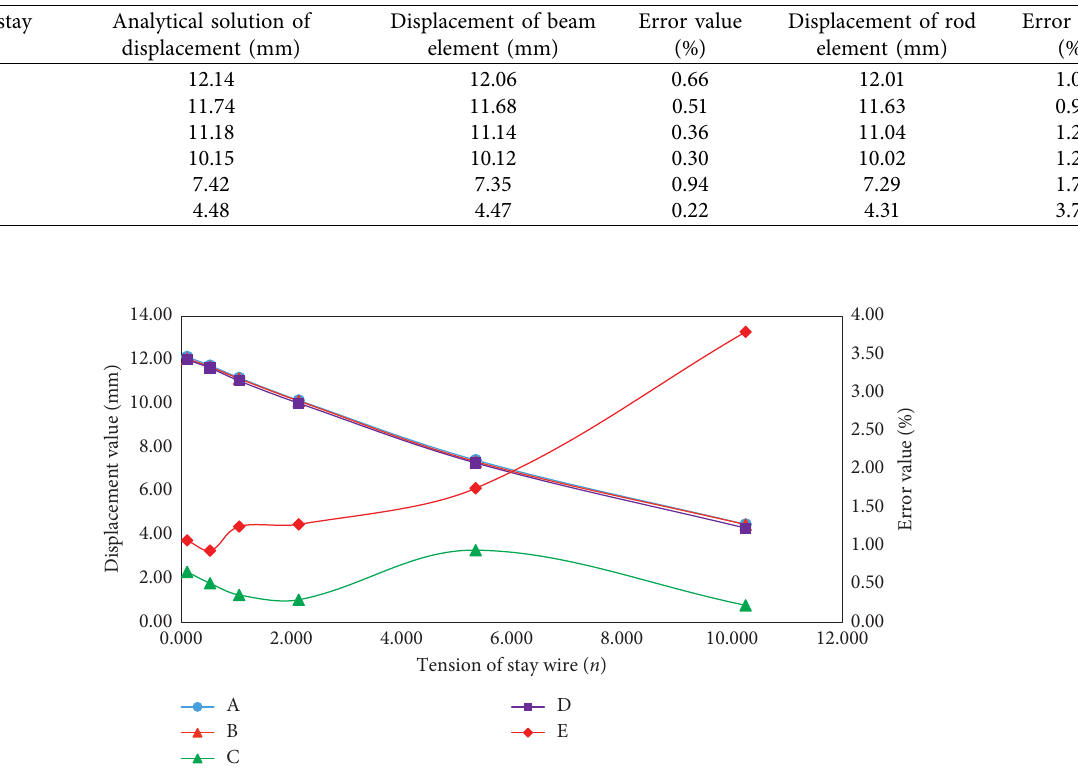
Figure 8: Simulation results of net tension of badminton beam